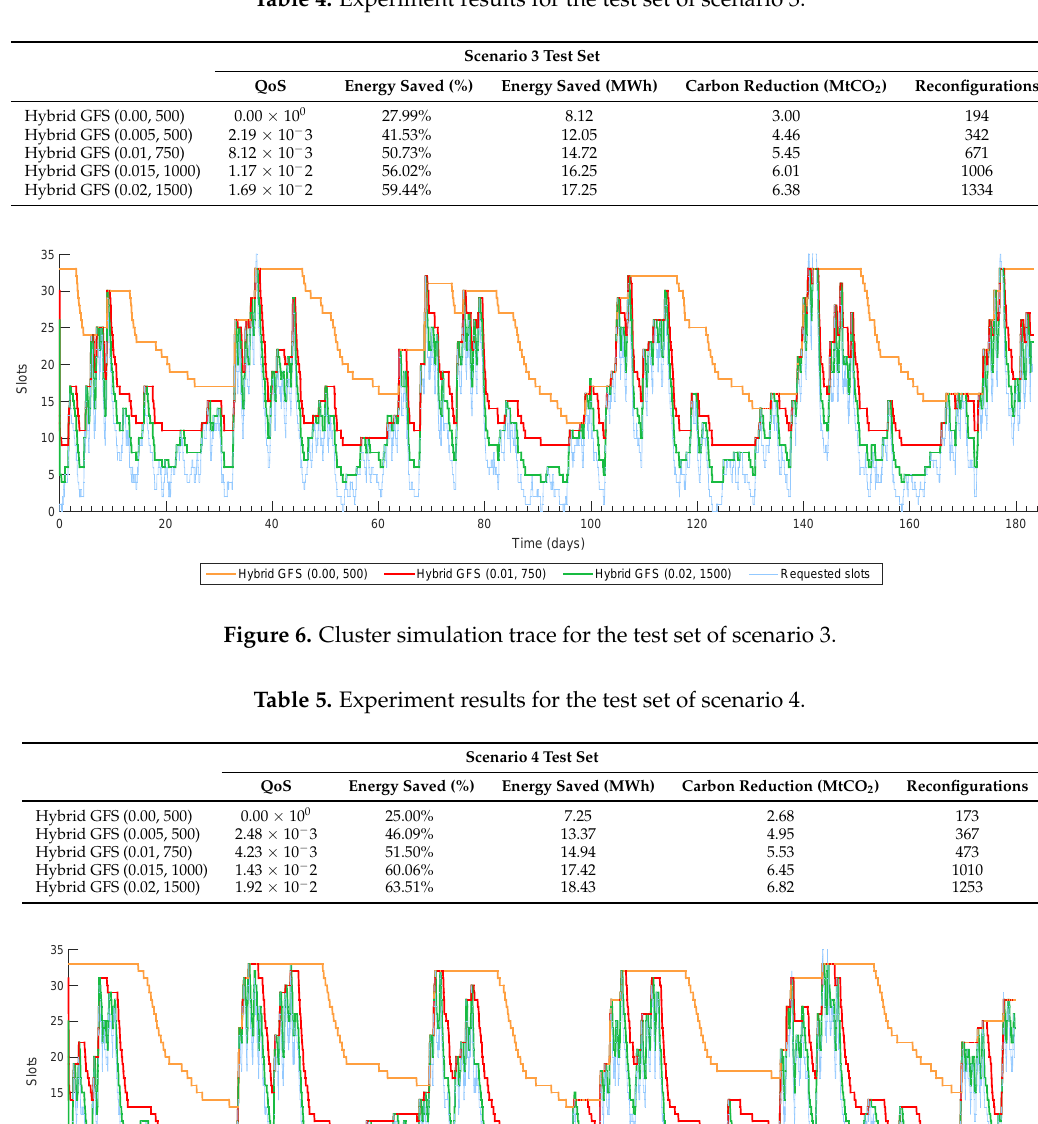
Table 4. Experiment results for the test set of scenario 3.